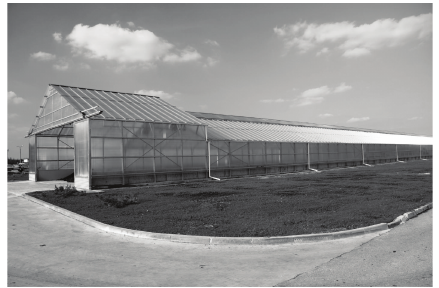
Figure 1: Solar drying plant in Iława.